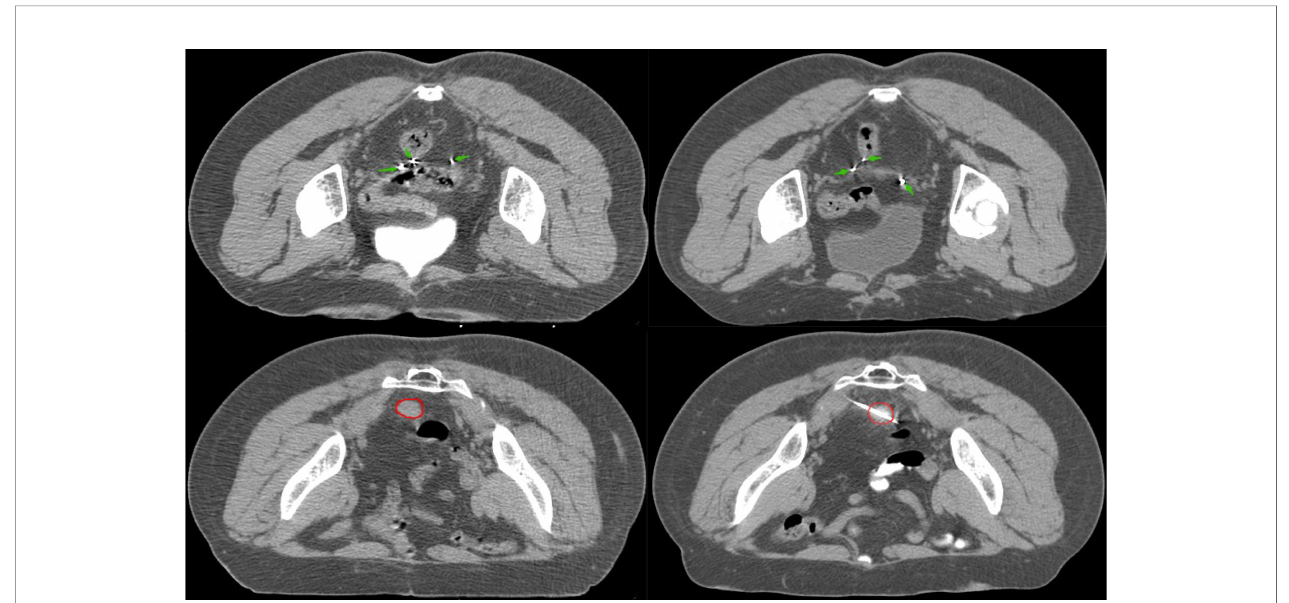
FIGURE 1 | There are twenty radioactive seeds in CT images of pelvic recurrence. The green arrow represents 125 I radioactive seed; the red circle represents